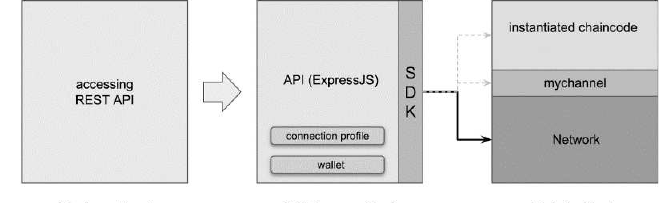
Fig. 2. Communication